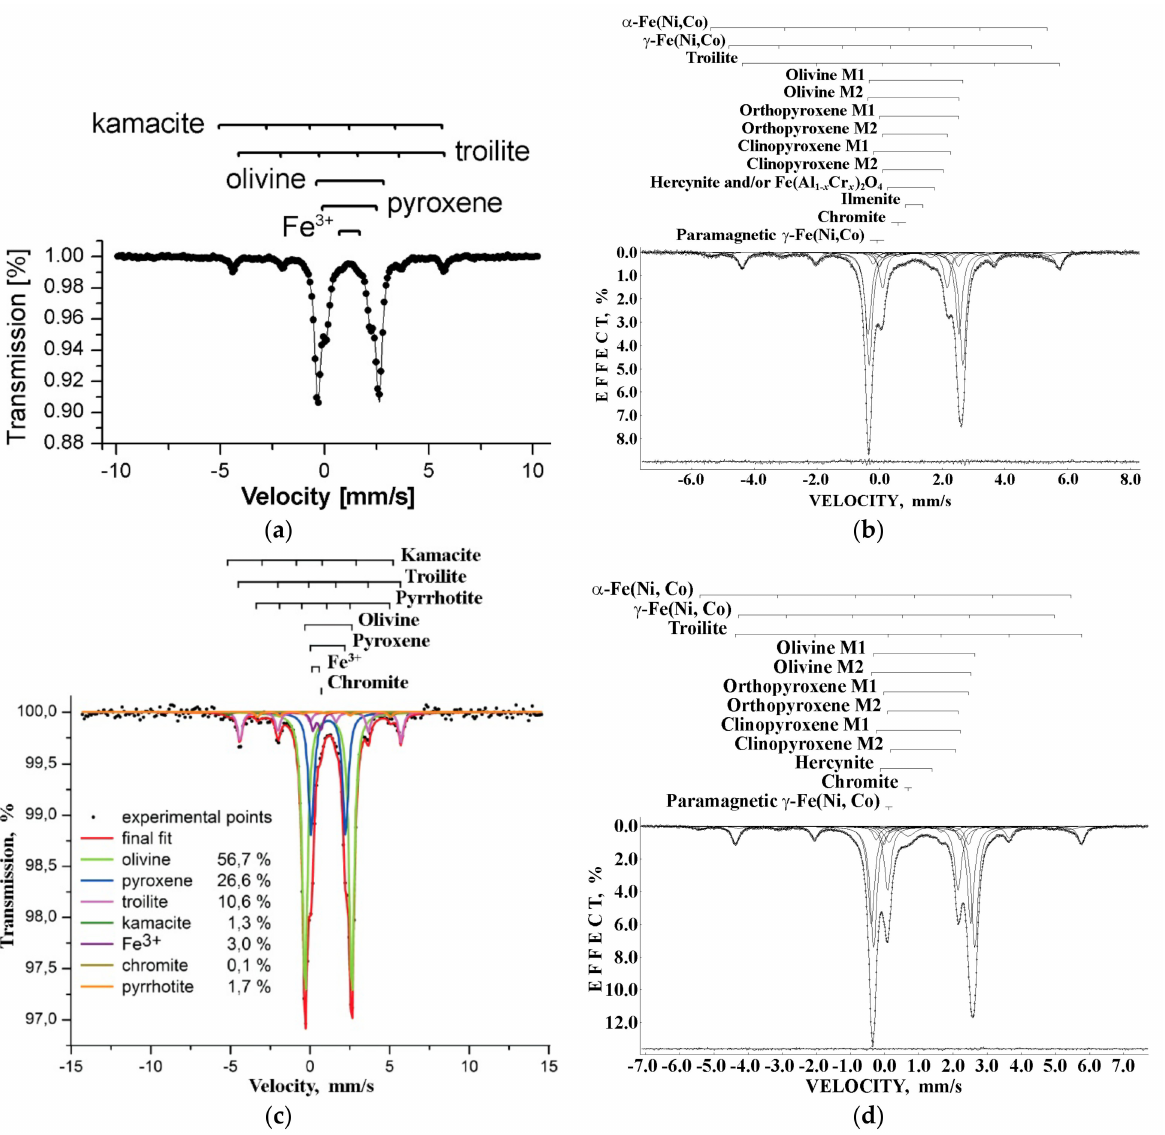
Figure 34. Room temperature Mössbauer spectra of equilibrated ordinary chondrites Chelyabinsk LL5 ( a , b ) and Bjurböle L/LL4 ( c , d ) measured with a low velocity resolution ( a , c ) [73,104] and with a high velocity resolution ( b , d ) [106,107]. Indicated components are the results of the fits. The differential spectra are shown on the bottom of the spectra ( b , d ). Adapted from References